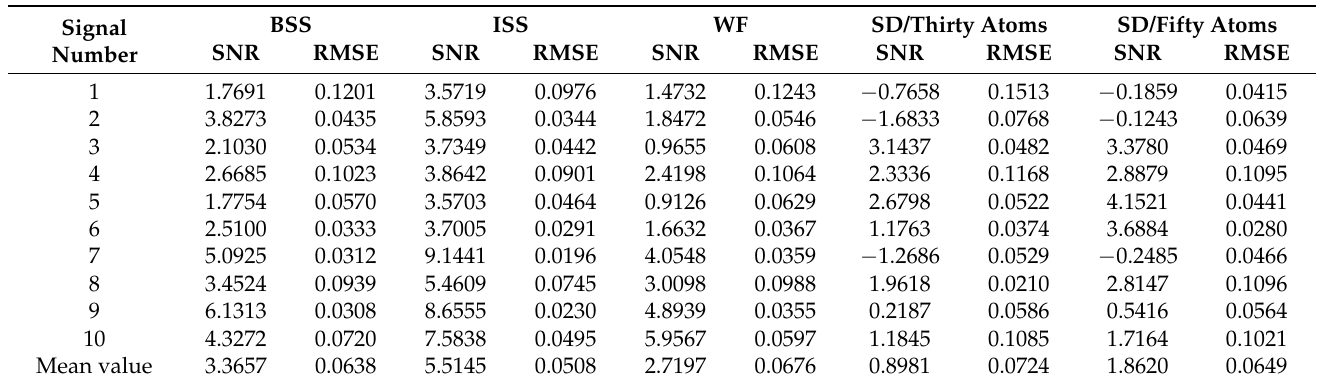
Table 1. SNR and RMSE of five signal filtering